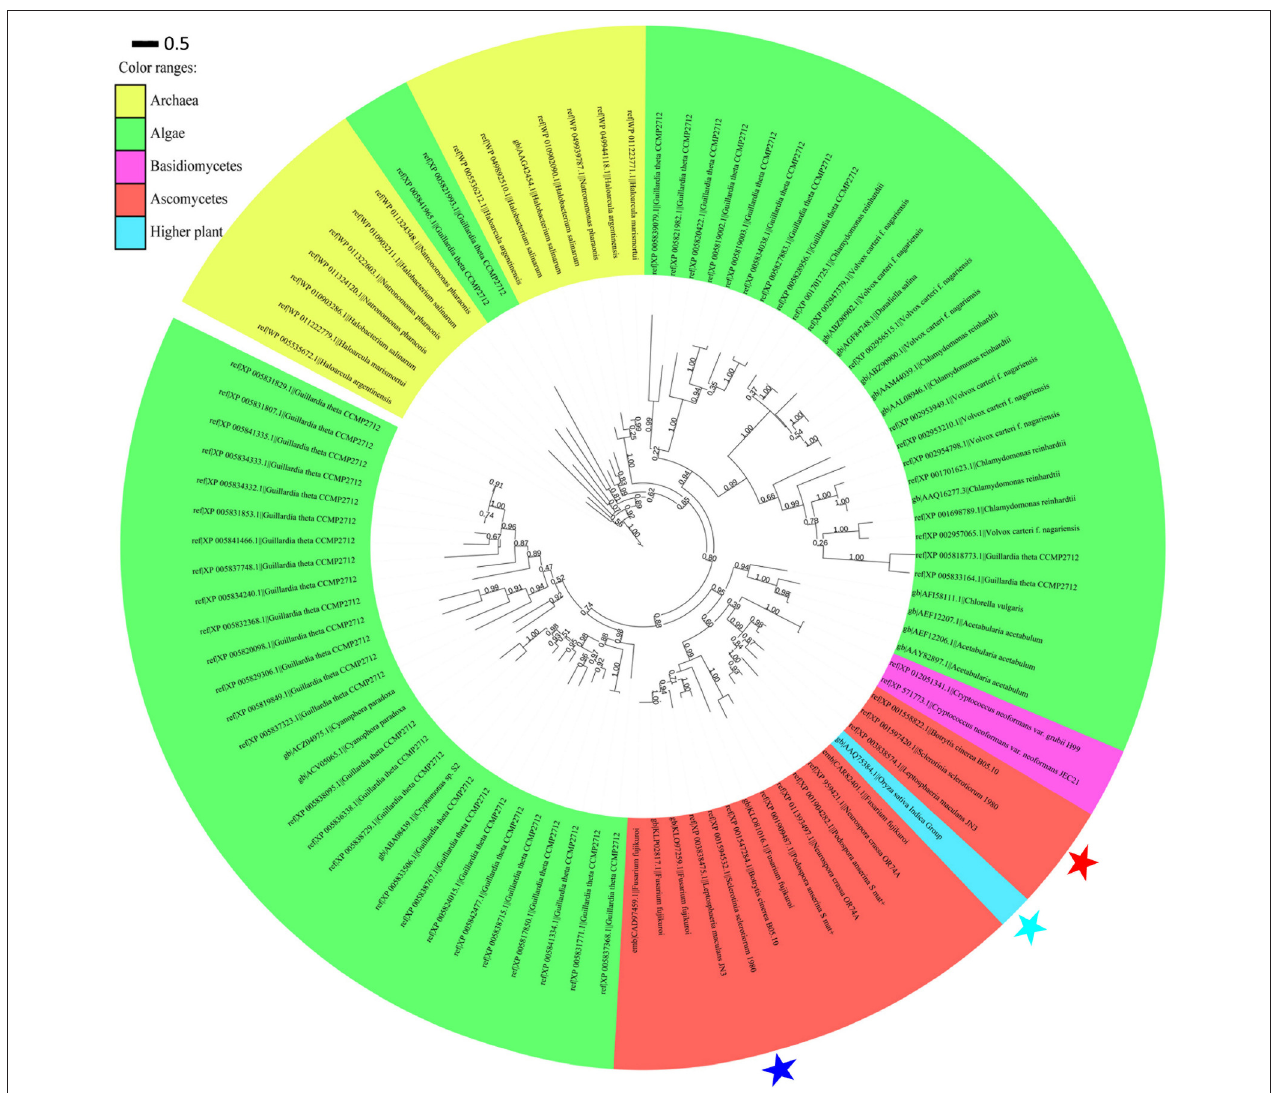
FIGURE 6 | Phylogenic analysis of type I microbial opsin homologs. A phylogenetic tree was built using the PhyML-mixtures based on a multiple protein sequence alignment generated using COBALT with the Constraint E -value parameter setting to 0.003. The approximate likelihood ratios (SH-test) are indicated. Sop1, sop2, and the putative rhodopsin (GenBank accession: AAQ75384.1) in the higher plant O. sativa indica group are indicated by the red, blue, and sky blue stars, respectively. The characters before and after “||” indicate the GenBank accession numbers and corresponding species and strains, respectively. The scale bar corresponds to 0.5 amino acid substitutions per